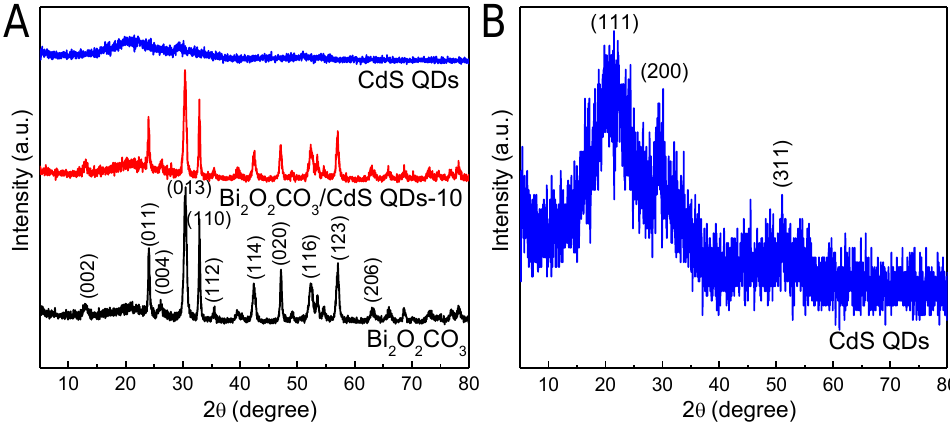
Figure 2. XRD patterns of the prepared Bi 2 O 2 CO 3 , Bi 2 O 2 CO 3 /CdS QDs-10 and CdS QDs photocatalysts ( A ); XRD curve of the pristine CdS QDs photocatalyst ( B ).